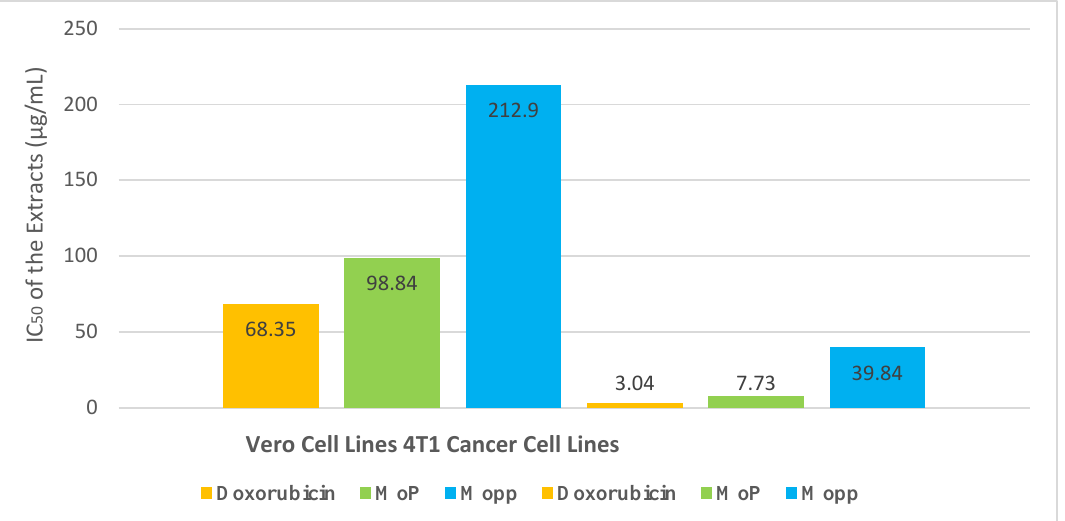
Figure 8. CC 50 (concentration of the drug that reduces cell viability by 50%) and IC 50 (concentration that inhibits 50% of breast cancer cells) of doxorubicin (standard drug) and extract (Mopp and MoP) comparisons toward Vero cell lines and 4T1 cell lines.